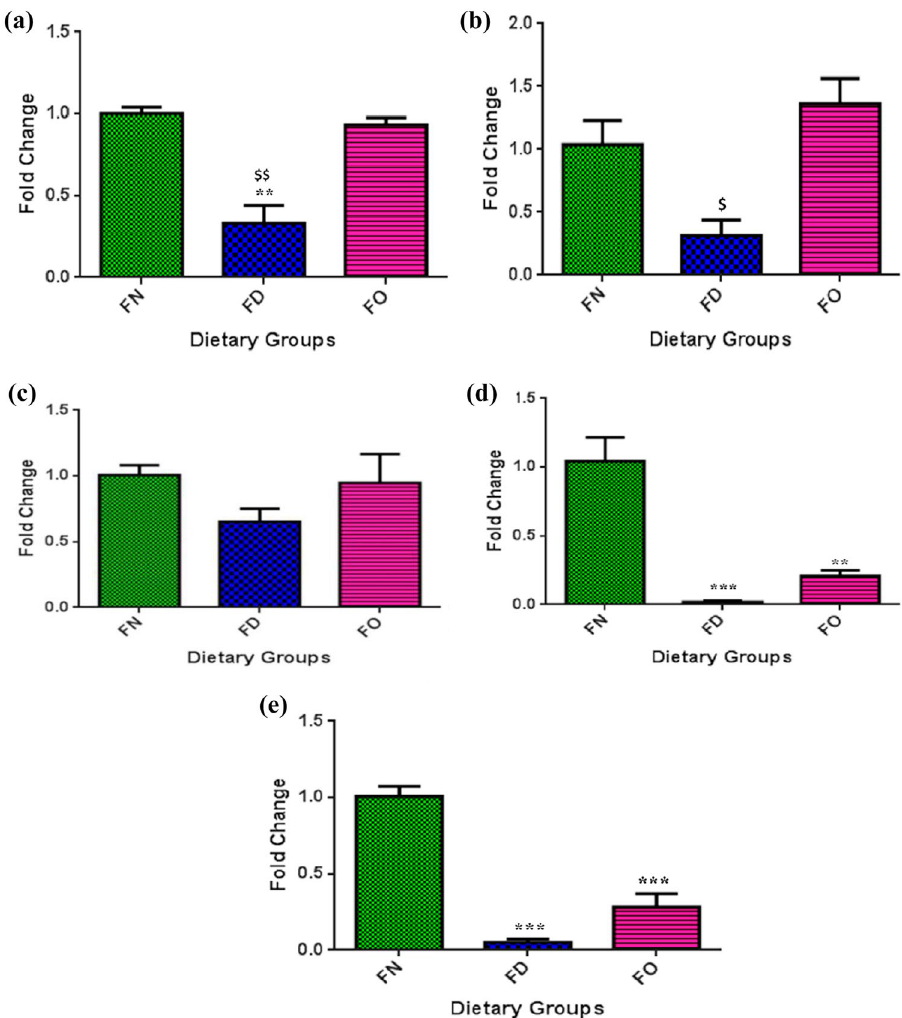
Figure 5. Effect of folic acid deficiency and oversupplementation on the gene expression of tumor suppressor genes: ( a ) DPT ( b ) RUNX3 ( c ) p16 ( d ) RASSF1A and ( e ) SOCS1 . 18S was used to normalize expression of studied genes. ** P < 0.01, *** P < 0.001 versus FN, $ P < 0.05, $$ P < 0.01 versus FO; FN-Folic acid normal, FD-Folic acid deficient, FO-Folic acid